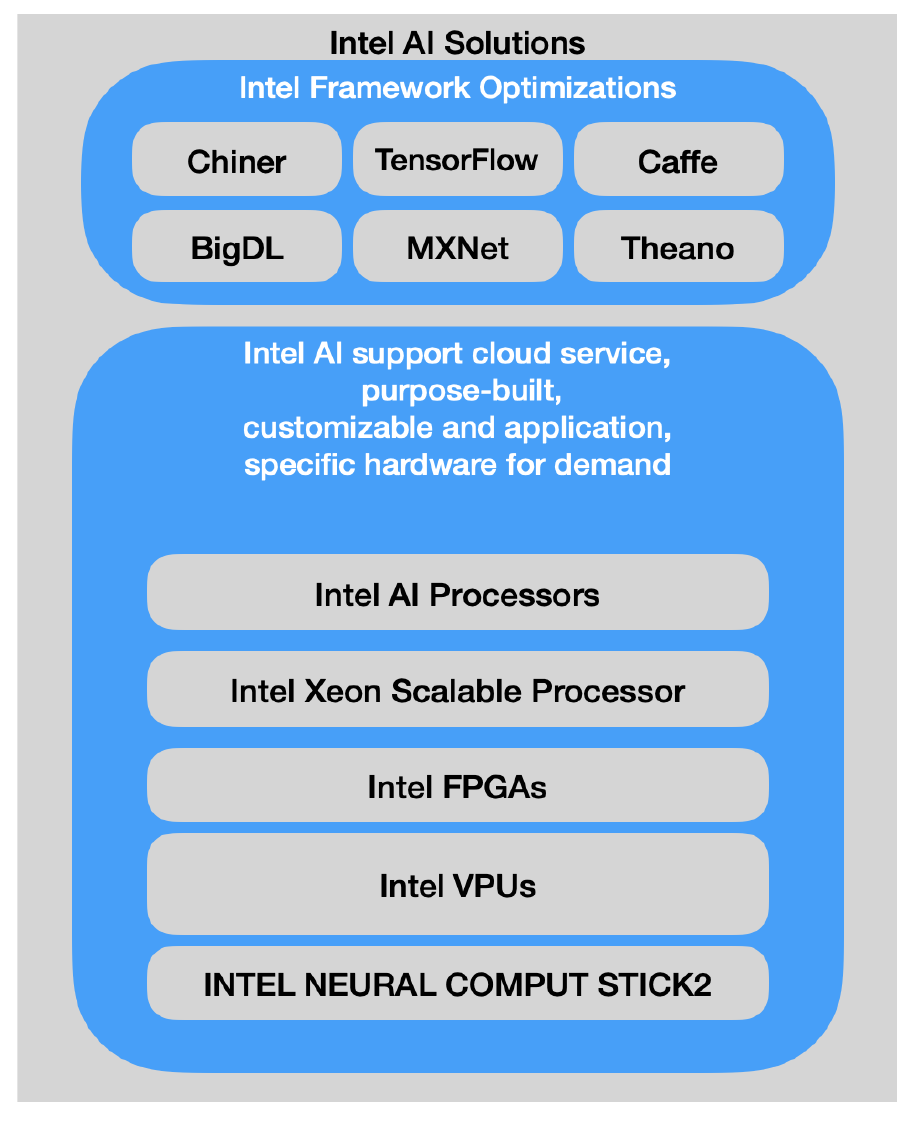
Figure 12. Intel AI and deep learning solutions